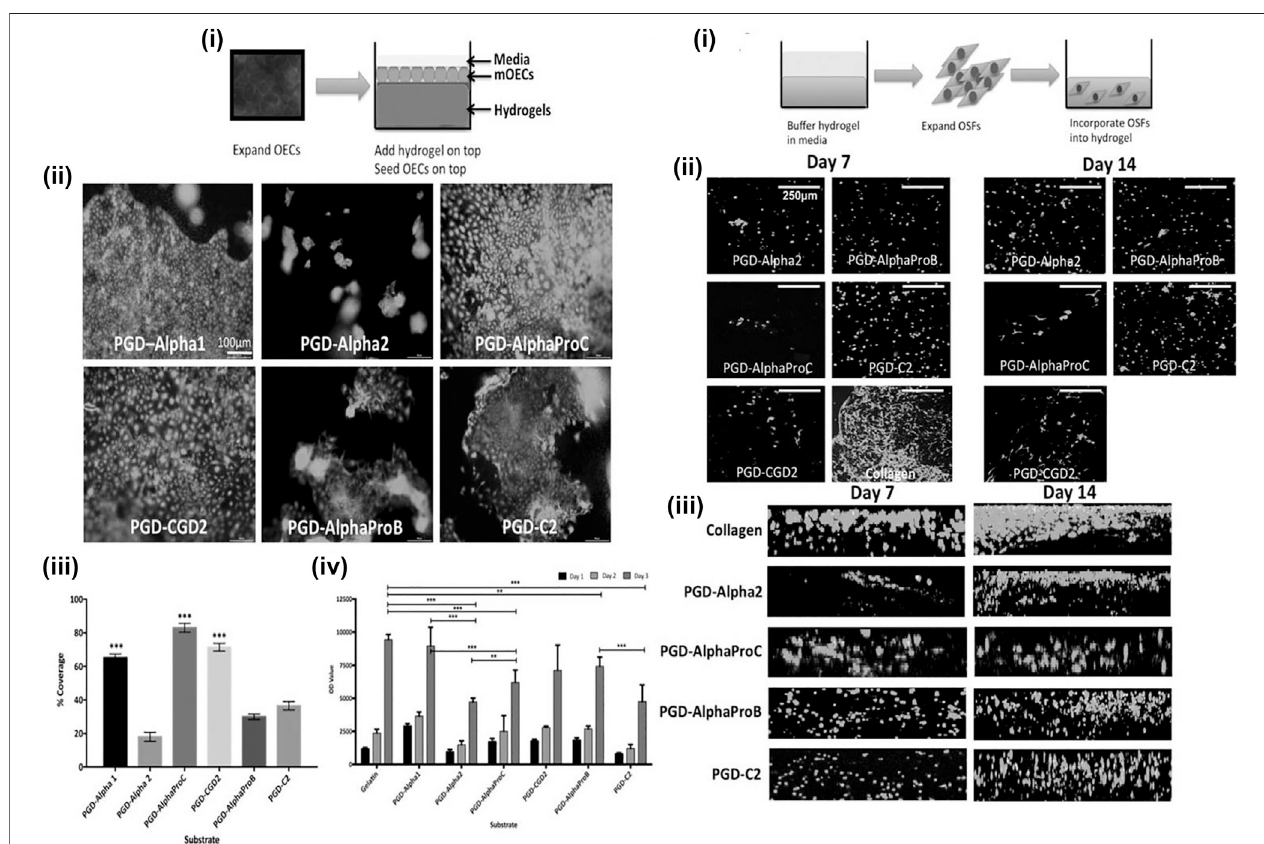
FIGURE 4 | The behaviors of mouse esophageal epithelial cells (mOECs) and rat esophageal stromal fi broblasts (rOSFs) cultured on the surface of peptide hydrogels (A) and embedded within peptide hydrogels (B) . [A (i)] Schematic diagram of mOECs cultured on the surface of peptide hydrogels. [A (ii)] The viability and proliferation of mOECs cultured on different peptide hydrogel surfaces for 3 days. [A (iii, iv)] The assessment of metabolic viability of mOECs cultured on the surface of differentpeptidehydrogelsatdifferenttimepoints. [B(i)] SchematicdiagramofrOSFsculturedintopeptidehydrogels. [B(ii)] TheviabilityandproliferationofrOSFs cultured into different peptide hydrogels. [B (iii)] The distribution of rOSFs within the different peptide hydrogels at the culture time point of 7 and 14 days. Reproduced from Kumar et al. (2017). Copyright (2017), with permission from John Wiley and Sons.